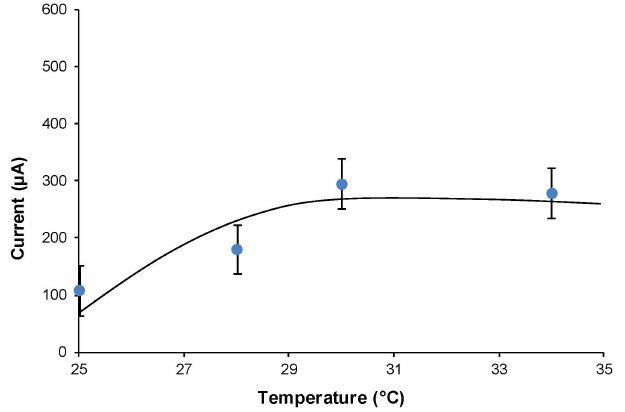
Figure 5. Current intensity recorded as the incubation temperature increases, obtained using 56 mmol L − 1 of glucose concentration and 0.6 g in 30 mL of